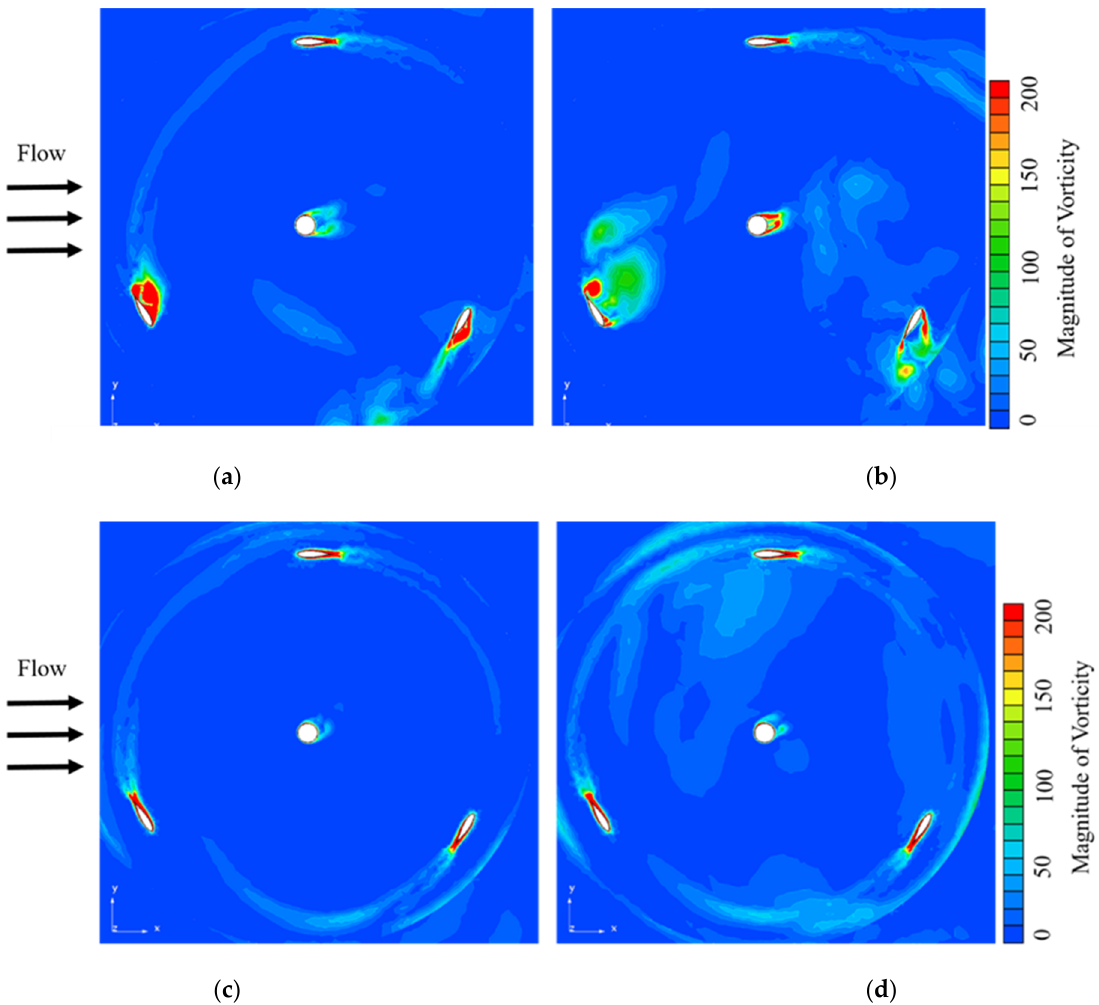
Figure 14. Vorticity with respect to tip speed ratio: ( a ) TSR = 1, ( b ) TSR = 2, ( c ) TSR = 3.5, ( d ) TSR = 5.